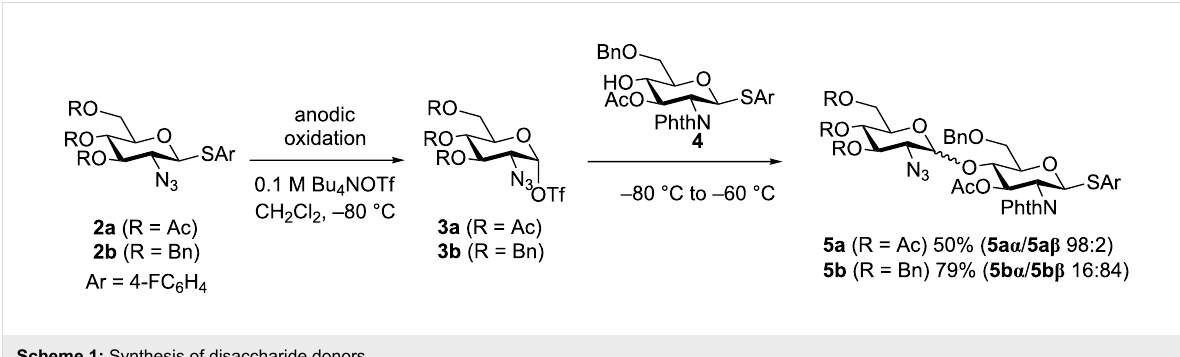
Scheme 1: Synthesis of disaccharide